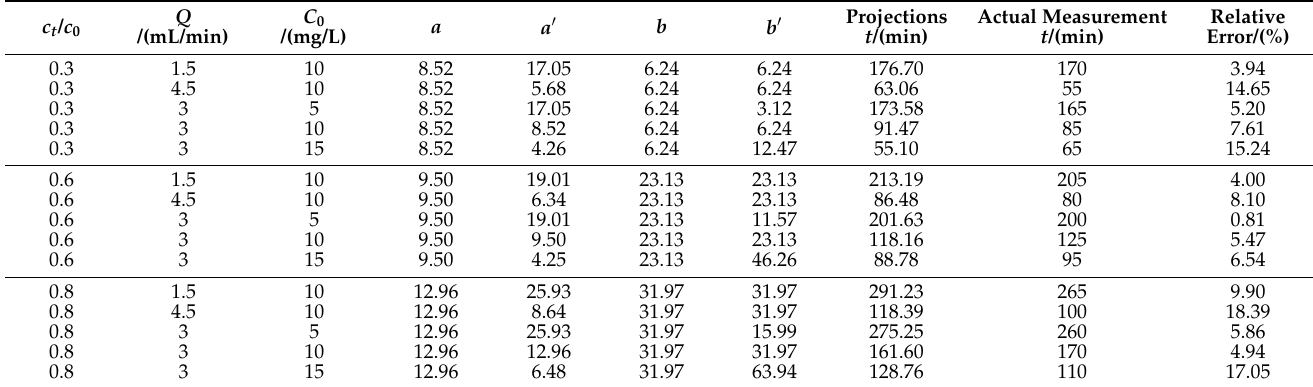
Table 5. BDST parameters for different